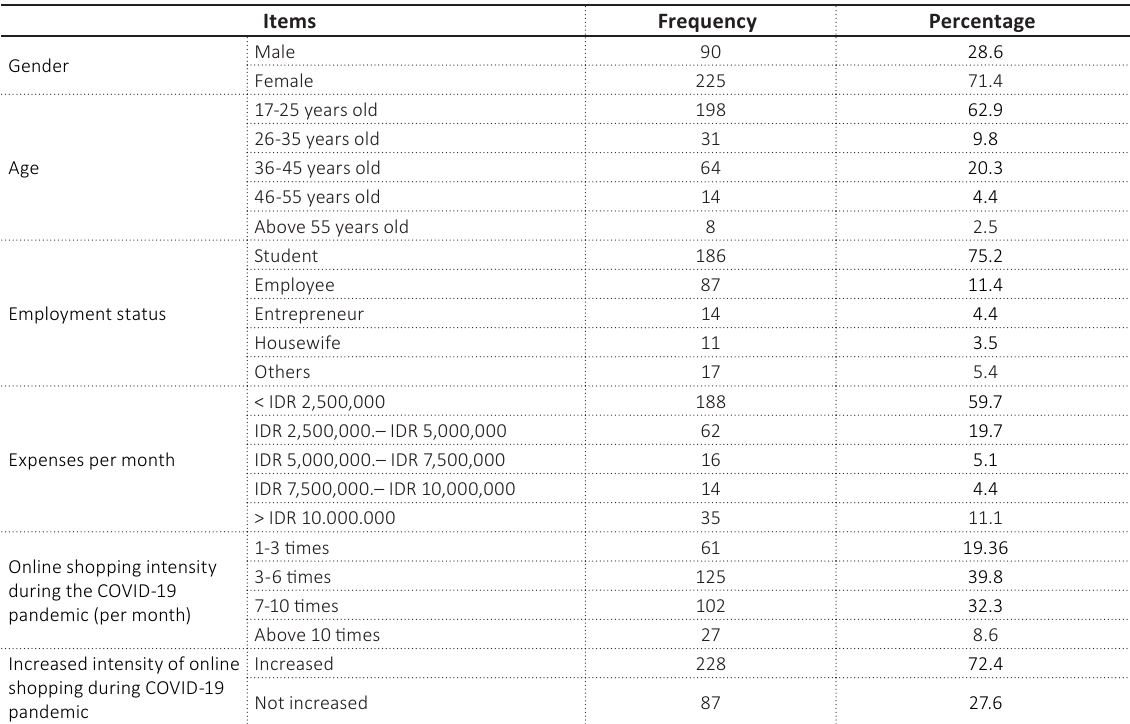
Table 1. Demographic profile of the